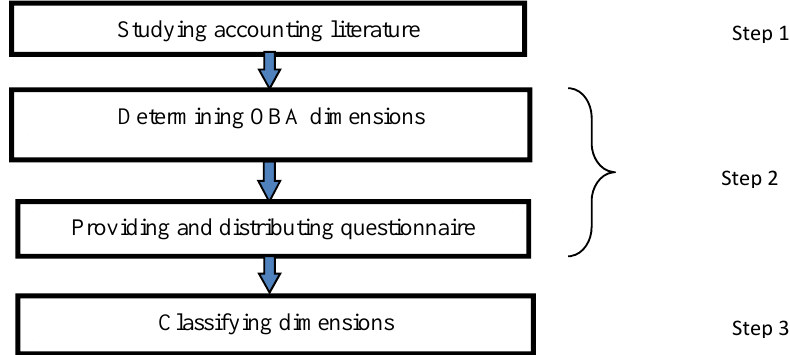
Fig. 2. Conduction process of the